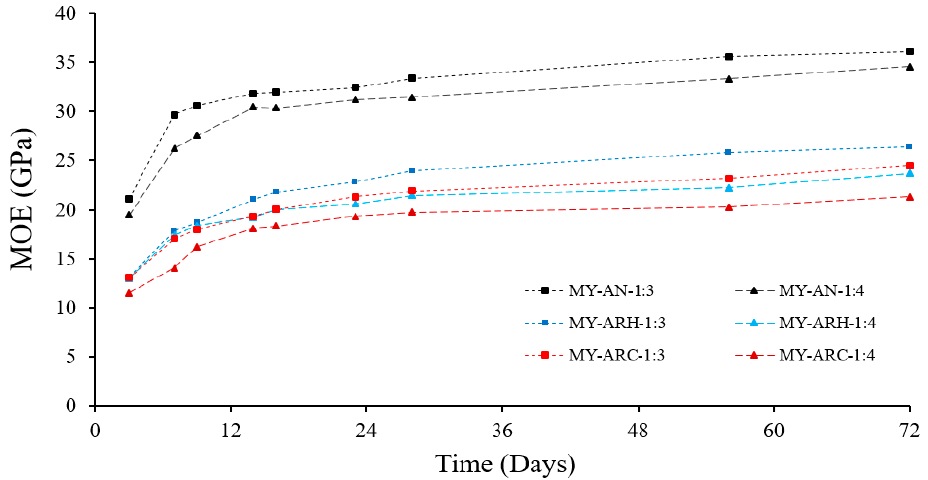
Figure 6 . Evolution of the dynamic Young’s modulus (MOE) (GPa) versus time (days) for the prepared mortar specimens. mortar